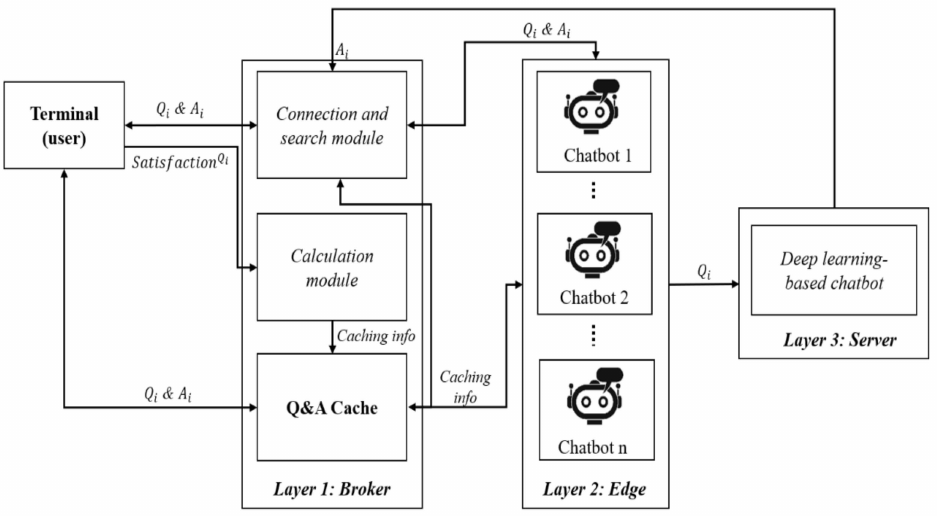
Figure 1. System architecture of video tutoring assistant